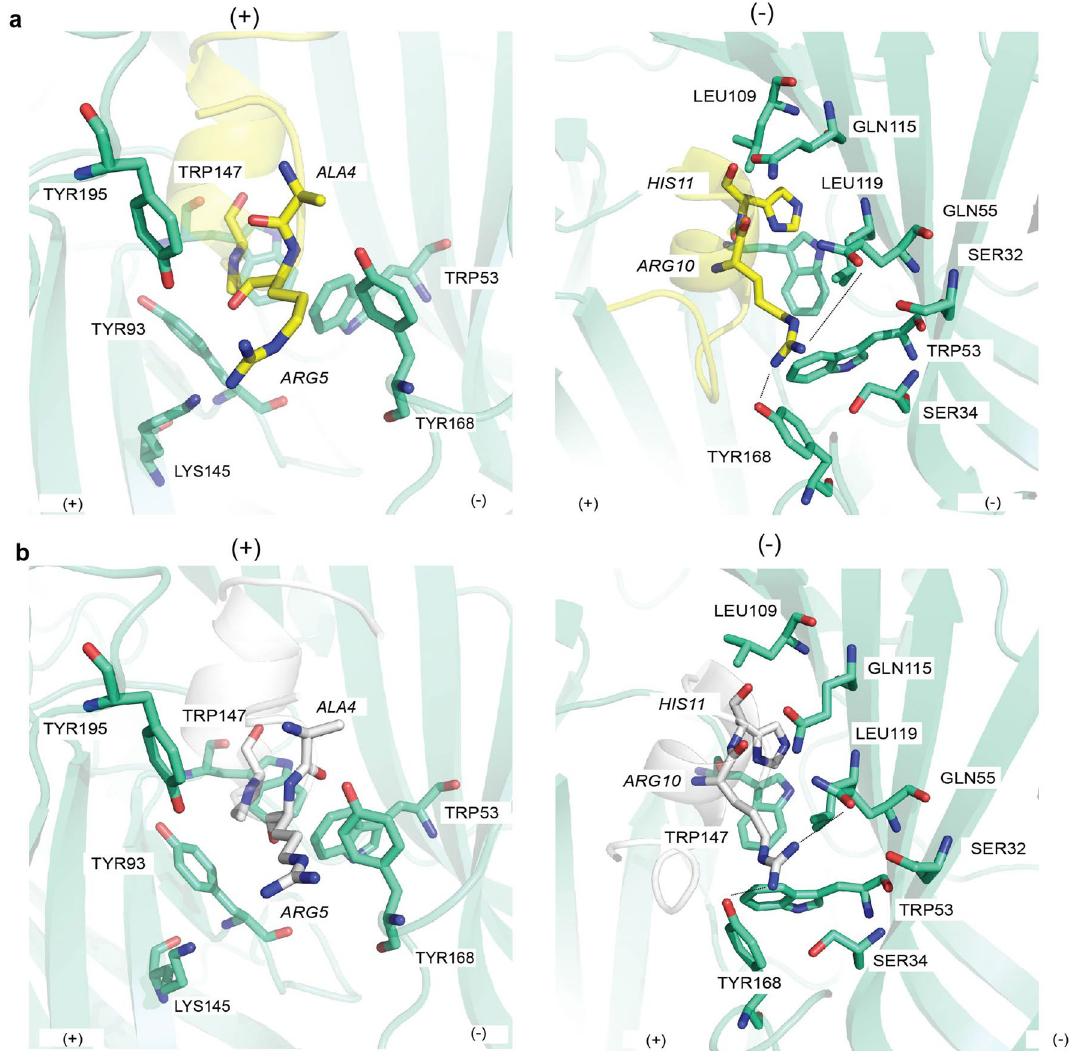
binding interactions at human α7 nAChRs. On the principal face, Ala4 only forms hydrophobic interaction with α7_Tyr168 ( Ls -AChBP_Tyr164), while a potential clash between Arg5 and α7_Lys155 could be made. Pro7 interacts mainly with aromatic side chain residues including Tyr93, Trp147 of the principal side and Trp55 of the complementary side. Arg10 makes the highest number of interactions on the complementary side, notably hydrogen bonds (dash lines) with α7_Gln55 and α7_Tyr166. The interacting surface of His11 consists of Trp147 on the principal side and Leu109, Gln117 and Leu119 on the complementary side of α7 nAChRs. AusIA residues are in italics. Interaction distances are listed in Supplementary Table